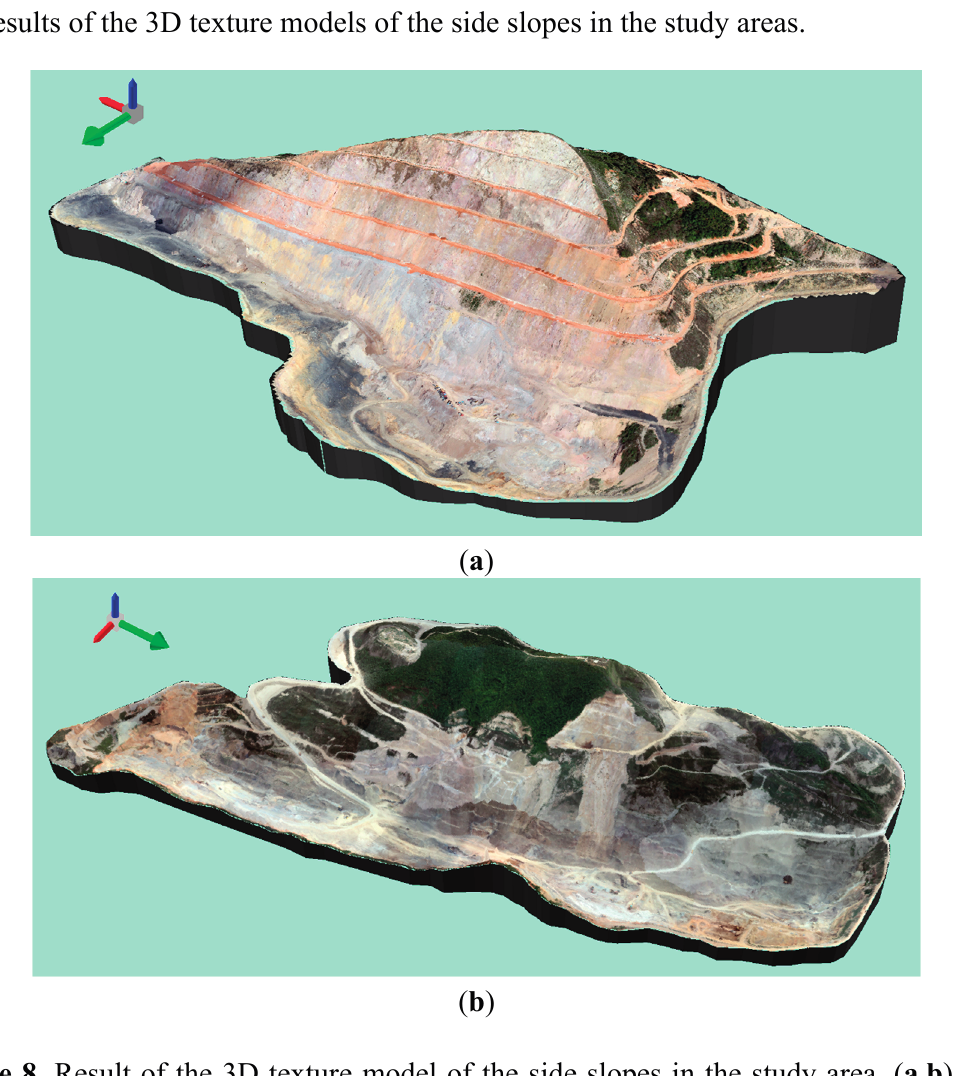
Figure 8. Result of the 3D texture model of the side slopes in the study area. ( a , b ) sided views from the top-left viewpoint with approximately 45° of the side slopes in Jianshan and Jinning areas,